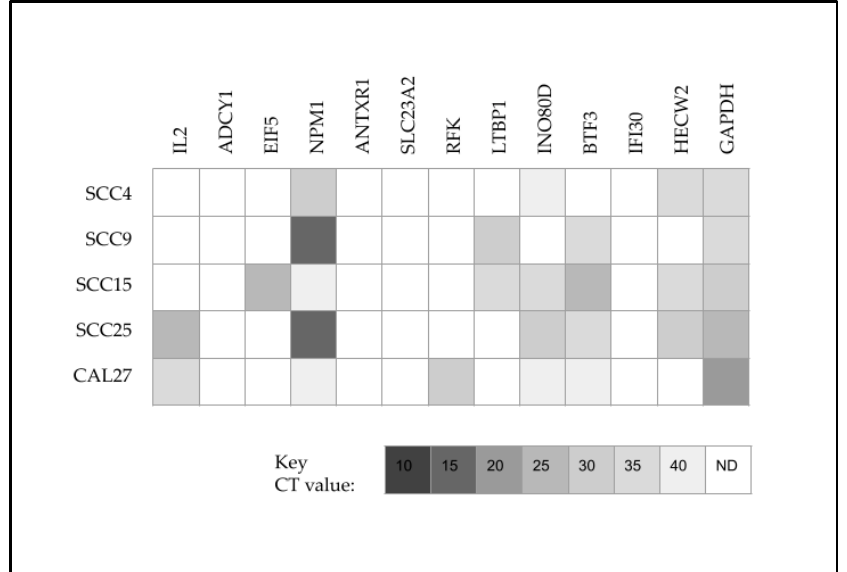
Figure 4. Screening of predicted downstream targets for miR-27. All cell lines expressed the positive control GAPDH and NPM1 with highest expression found in SCC9 and SCC25 cells. Expression of EIF5 was found among SCC15 cells with RFK only observed with CAL27 cells. None of the cell lines evaluated expressed ADCY1, ANTXR1, SLC23A2 or IFI30.